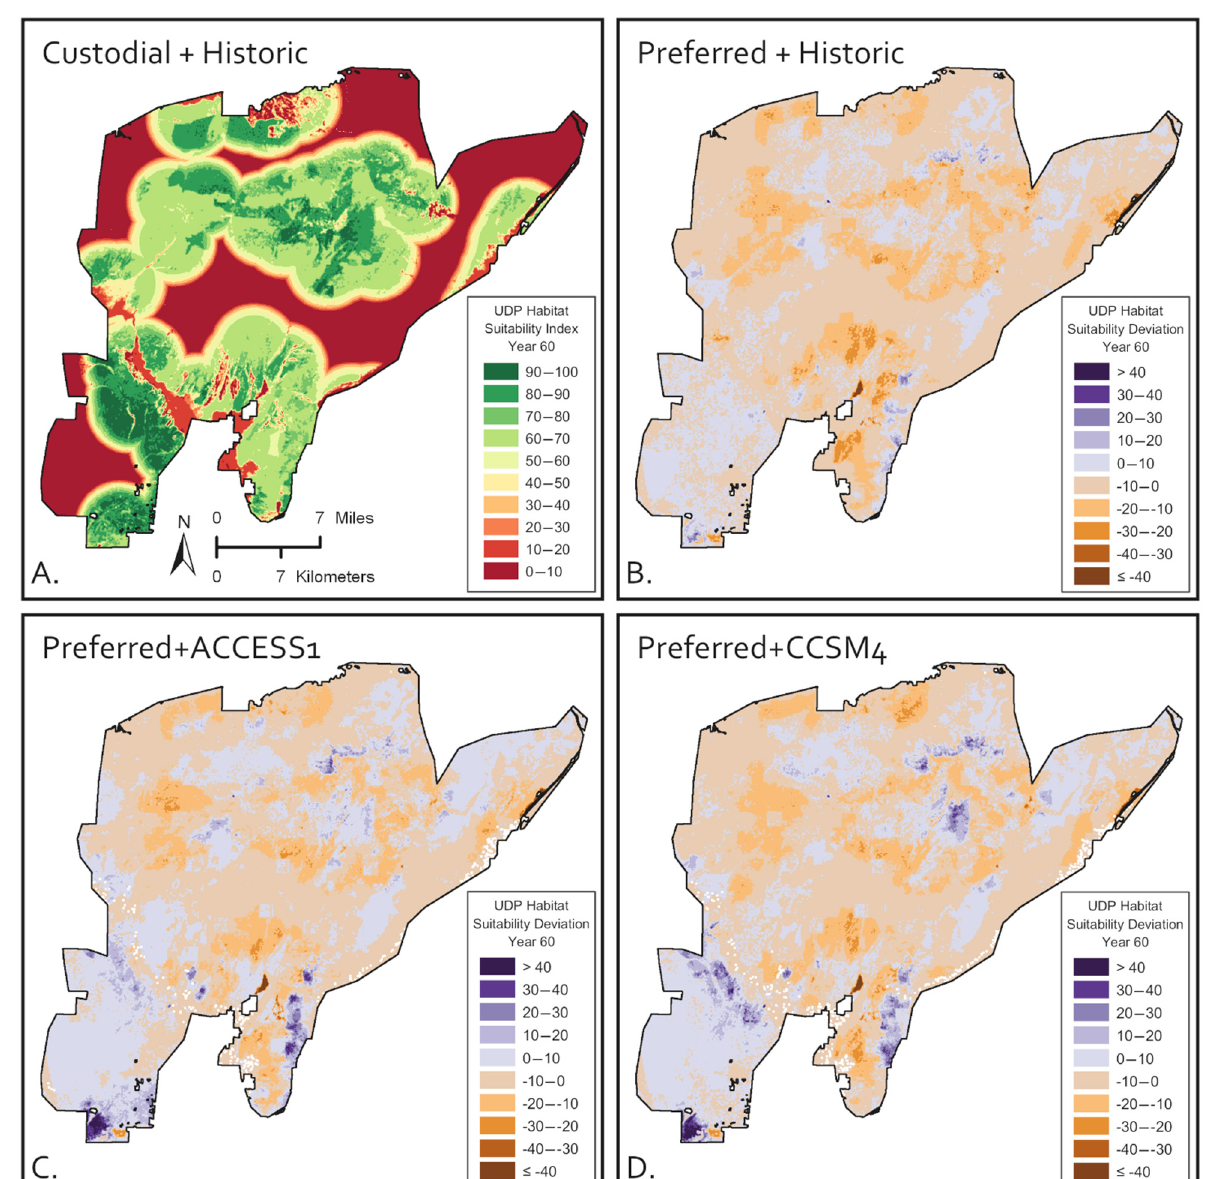
Figure 10. Habitat suitability for UPD in the Black Mountains at year 60 for the C USTODIAL + H ISTORIC ( A ) scenario, and absolute deviations from that standard for the P REFERRED + H ISTORIC ( B ), P REFERRED + ACCCES1 ( C ), and P REFERRED + CCSM4 ( D )scenarios, based on 2013 five-meter RapidEye satellite imagery.